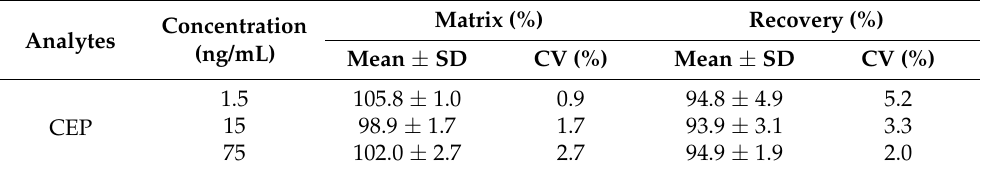
Table 2. Matrix effects and recovery of CEP in rat plasma ( n = 6).